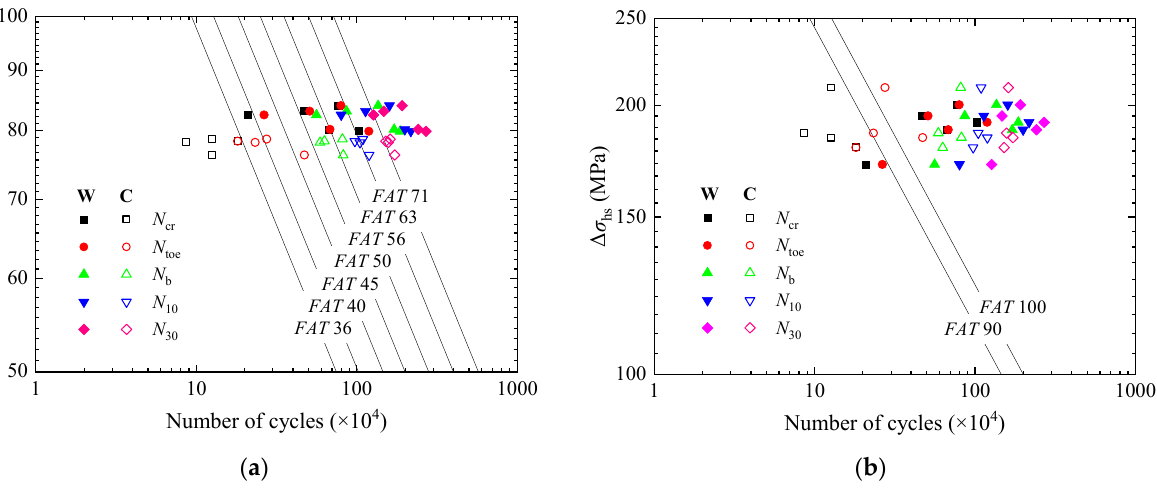
Figure 12. Comparison of fatigue data with S - N curves. ( a ) Nominal stress approach. ( b ) Hot spot stress approach.